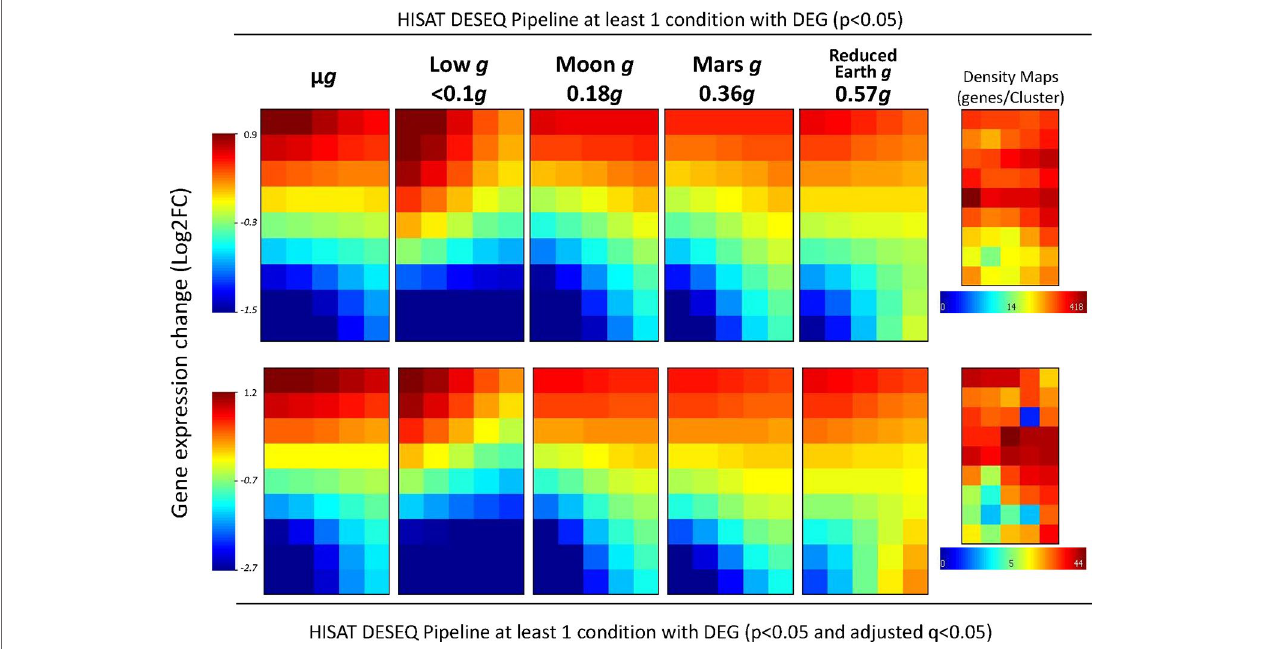
FIGURe 3 | Whole-genome transcriptional status variations along g -levels into the SG1/SG2 experiments (comparisons versus 1 g ). A 5x9 clustering analysis of the differentially expressed genes (in at least one of the partial g levels, using normal p values (first row, n = 5,571 genes) or adjusted q -values (second row, n = 861 genes) on the transcriptome have been done with the average of each gene expression level within a similarly expressed cluster across the samples. Values are shown according to the log2 ratio scales at the border of the figure (from highly overrepresented in red to highly down-represented in blue). The mean value of −0.3 or −0.7 indicates an overall repression in gene expression under microgravity. The gene density maps are shown in the middle of the figure for each analysis. Calculated g -levels have been obtained by considering replicates the more similar samples across the nominal µ g , 0.1 g , 0.3 g , 0.5 g , 0.8 g and 1 g (precisely, µ g (4 replicates), 0.09 ± 0.02 g (3 replicates), Moon level (0.18 ± 0.04 g , 3 replicates), Mars-level (0.36 ± 0.02 g , 3 replicates), 0.57 ± 0.05 g (4 replicates) and control 1 g (0.99 ± 0.06 g , 3